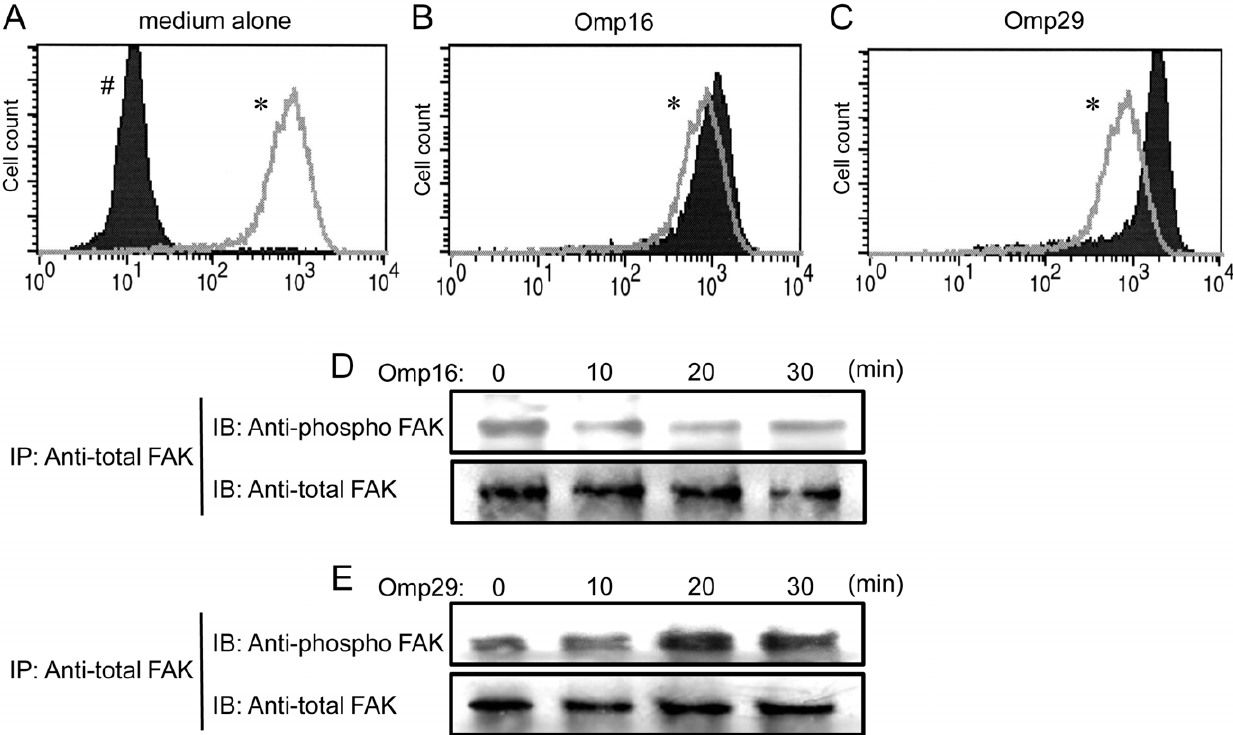
Figure 5. Omp29 induces actin rearrangement and FAK phosphorylation in OBA9. (A–C) The confluent OBA9 cells in the tissue culture flask were incubated for 1 hour in medium alone (A) or in the presence of Omp16 (10 m g/ml) (B) or Omp29 (10 m g/ml) (C). In order to stain F-actin, OBA9 cells removed from culture plate by trypsin-EDTA were permeabilized and stained with FITC-Phalloidin. (A) The solid histogram # shows the non-stained OBA9 and the open histogram in gray line * indicates the FITC-Phalloidin staining of OBA9. (B and C) The open histogram * indicates the FITC-Phalloidin stained OBA9 incubated with medium alone and the solid histograms display the staining of OBA9 stimulated with Omp16 (B) or Omp29 (C), respectively. (D and E) After stimulation of OBA9 cells with Omp16 (10 m g/ml) (D) or Omp29 (10 m g/ml) (E) for the time periods shown in the figure, whole cellular proteins dissolved in lysis buffer were immuno-precipitated with anti-total FAK antibody bound to GammaBind Plus Sepharose beads. The proteins pulled down with the beads were blotted onto NC membrane and reacted with anti-total FAK antibody or anti- phospho FAK antibody using Western-blot method.